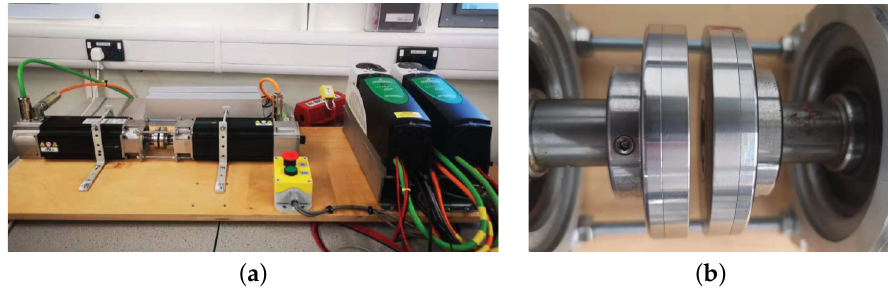
Figure 1. Experimental test rig ( a ) motor- and load-side actuation ( b ) magnetic coupling.